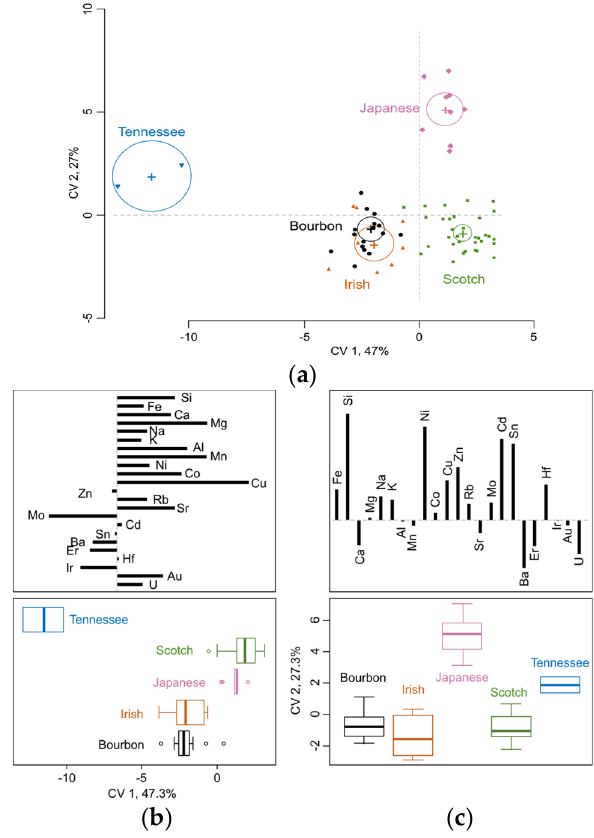
Figure 1. Canonical Variate Analysis (CVA) plots, showing the separation of different whiskies by their elemental composition: ( a ) CVA score plot showing the 95% confidence intervals for each of the five different types, together with the 68 whisk(e) samples, coded by their type (blue down ‐ facing triangle … Tennessee; orange up ‐ facing triangle … Irish; black circles … Bourbon; green squares … Scotch; violet diamond … Japanese); ( b ) Boxplot and total structure coefficients for the first canonical dimension (CV 1), showing the contribution of each element to the separation along CV 1; ( c ) Boxplot and total structure coefficients for the second canonical dimension (CV 2), showing the contribution of each element to the separation along CV 2.